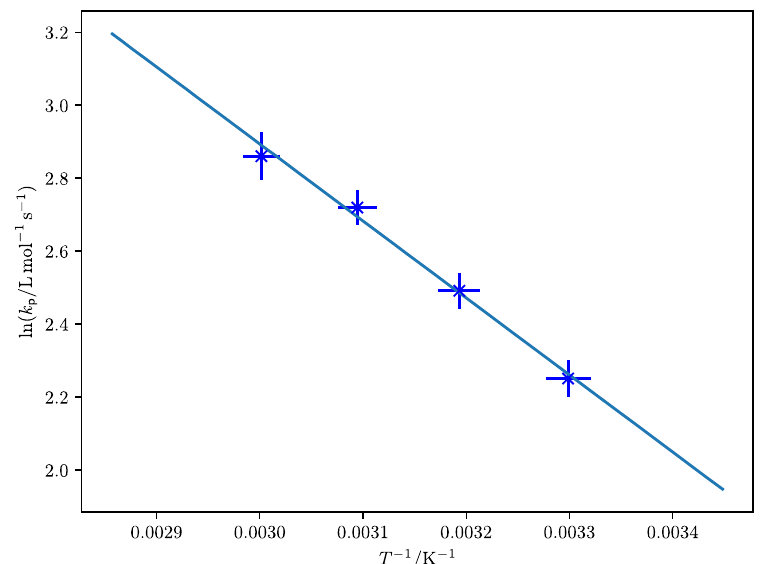
Figure 7. Arrhenius fit for k p of DEI. The indicated uncertainties in ln( k p ) result from the standard deviation of the measurements for the respective temperature, while for the uncertainty in T − 1 an uncertainty of ∆ T = 2 K was assumed. For 30 ◦ C, only one data point exists, consequently the uncertainty in ln( k p ) was assumed to be similar to the other values. The obtained Arrhenius parameters are shown in Table 5. Table 5. Experimental Arrhenius parameters for chain ‐ length ‐ averaged k p of DnPI, obtained via PLP ‐ SEC.